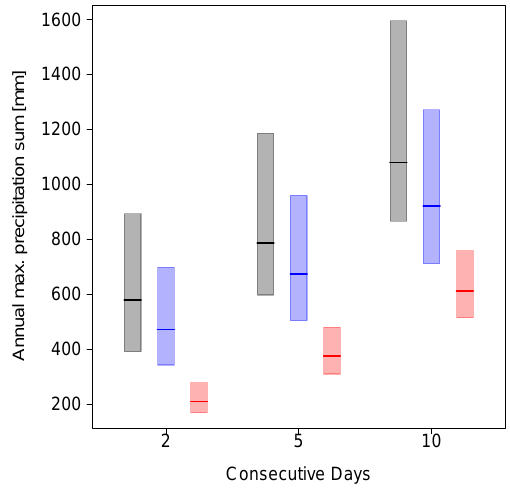
Figure 8. Annual maximum precipitation summed over all eight stations and over consecutive days. The analysis is done for all days of the year. The bars (horizontal line) indicate the range between the 2.5 and 97.5% empirical quantiles of the yearly maximum area sums during 1961–2011. The observations are plotted in grey, the multi-site simulations in blue and the single-site simulations in red. The observations comprise 51 years, and the models were run 100 times over a 51-year time